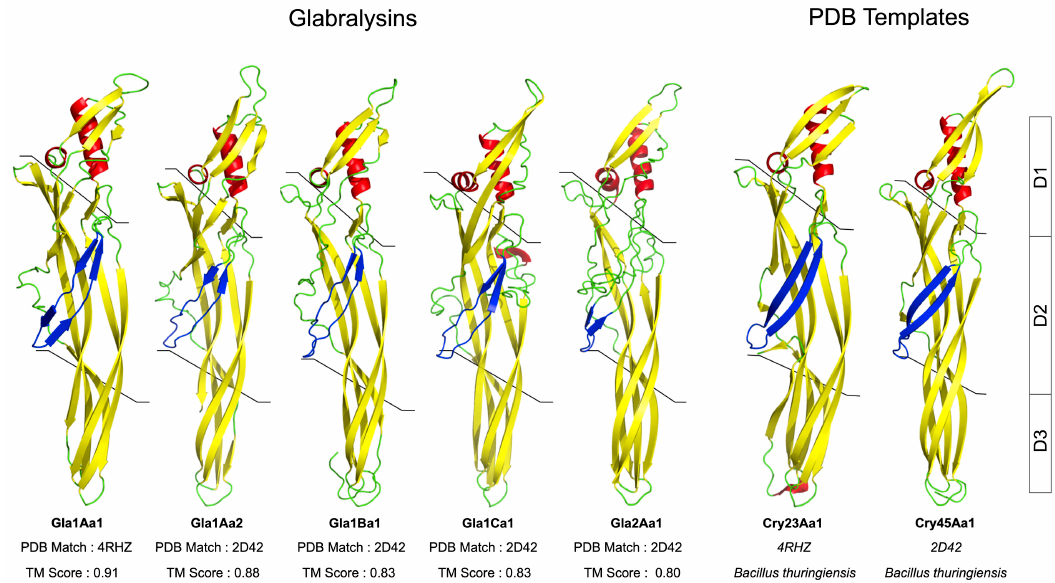
Figure 3. Structural prediction of the Glabralysins. Three-dimensional structure prediction of the five Glabralysins was performed using I-Tasser server with the structure of Cry23Aa1 (4RHZ) and Cry45Aa1 (2D42) as best templates. Surface representation was realized with PyMol software. Beta sheets in yellow, coils in green, alpha helix in red and TMD domain in blue. The three conserved domains (D1, D2, D3) are delimited by lines and described by boxes to the right of the figure. A TM-score was calculated between the Glabralysins and the best hit found by I-Tasser server. A score greater than 0.5 reveals significant alignment, whereas a TM-score less than 0.17 indicates random similarity.